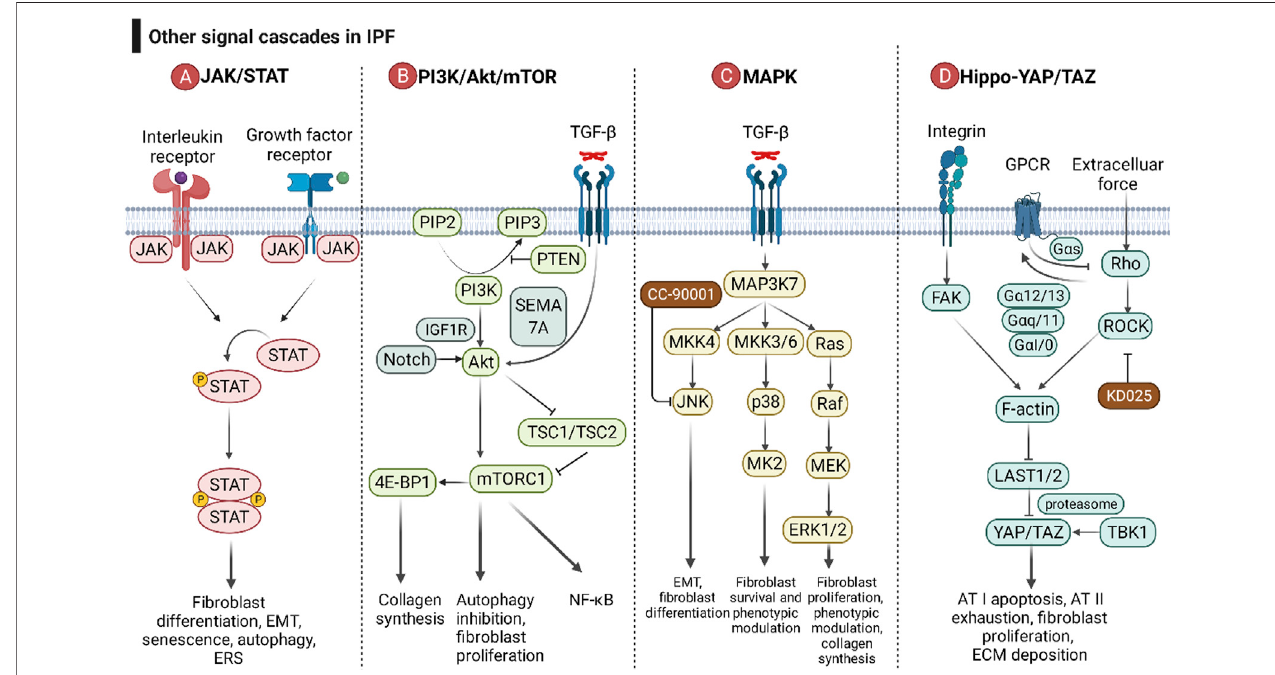
FIGURE6| TherolesoftheJAK/STATpathway,PI3K/Akt/mTORpathway,MAPKpathway,andHippo-YAP/TAZpathwayinIPF. (A) Afterinterleukinsandgrowth factorsbindtothecorrespondingreceptors,theycanactivatetheJAKscoupledtothereceptors,andthenJAKscanphosphorylateSTAT.HomodimerizedSTATenters thenucleusandaffectsgenetranscription. (B) Growth factorsandcytokinescanactivatePI3Kbybindingtoreceptor-typetyrosinekinases,andthenPI3Kcatalyzesthe phosphorylation of PIP2 to PIP3. PIP3 can activate Akt and its downstream mTOR complex (mTORC). PTEN is a negative regulator of the PI3K/Akt/mTOR pathway. TGF- β and Notch are positive regulators of Akt. (C) The MAPK pathway consists of three downstream cascades, the JNK, p38, and ERK pathways. JNK and p38 signaling are activated through a pattern of MAP3K-MAP2K-MAPK signaling cascades, while ERK is activated through the MAP3K-Ras-Raf-MEK-ERK cascade. MK2 is a downstream signaling molecule of p38. Growth factors can activate ERK5, and ERK5 and p90RSK can acetylate Smad, thereby promoting the TGF- β /Smad pathway. (D) The Hippo-YAP/TAZ pathway is involved in pulmonary fi brosis through the integrin pathway, G protein-coupled receptor pathway,